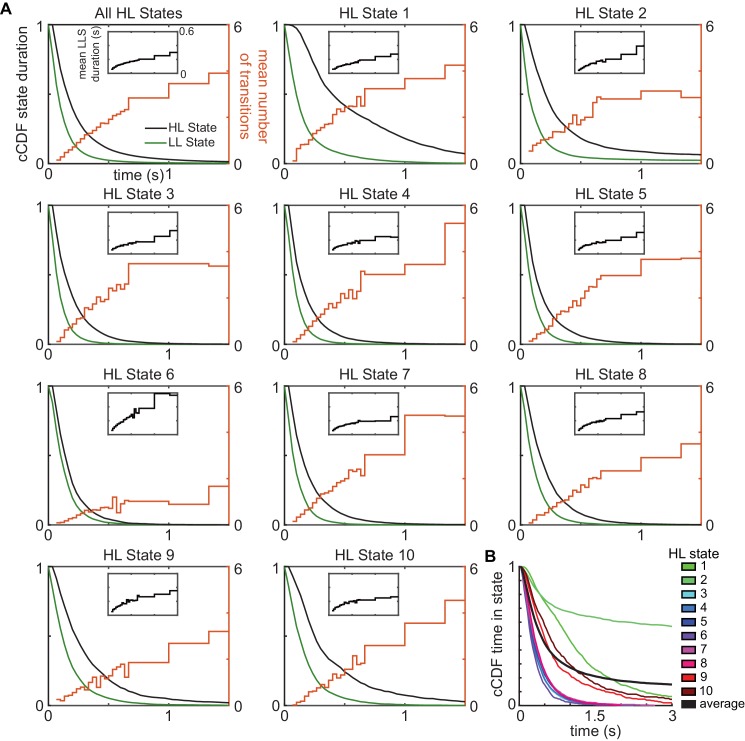
HL states have a longer duration than LL states because of multiple transitions among low-level states/transition between HL states.(A) Complementary cumulative distribution (cCDF) of durations for HHMM HL states (black) and the corresponding LL states (green). Mean number of LL state transitions per HL state transition increases with the duration of the HL state (orange). Inset black line shows the mean duration of LL states for each HL state track. (B) cCDF of the total time spent in a state of a given duration.